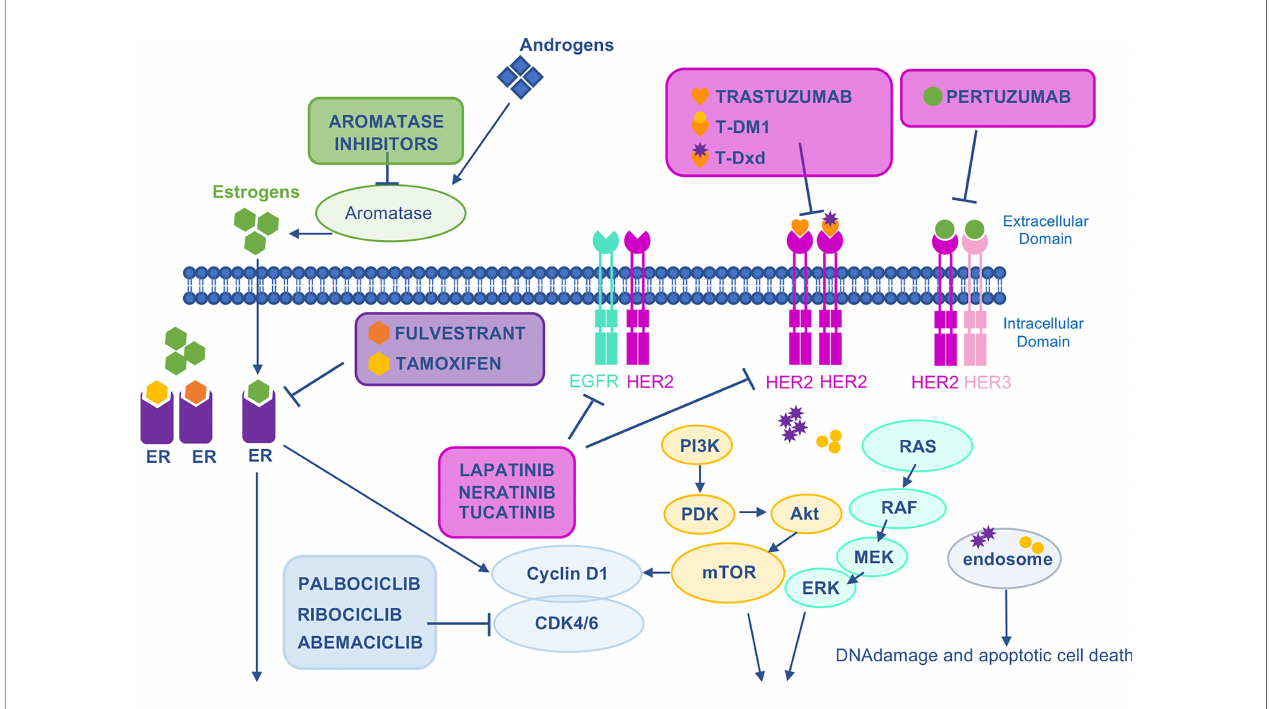
FIGURE 2 | Mechanism of action of HER2 – , ER – , and CDK4/6 – targeted drugs. HER family RTKs (EGFR, HER2, and HER3) activate several oncogenic signaling pathways such as Ras/Raf/MEK/ERK or PI3K/Akt/mTOR to stimulate growth and proliferation. Direct HER2 inhibitors include trastuzumab and the conjugates of trastuzumab with DM1 (T – DM1) or Dxd (T – Dxd). In the case of drug – antibody conjugates, upon binding of trastuzumab to HER2, the payload is internalized by endocytosis to induce DNA damage. Pertuzumab mAb binds HER2, preventing homodimerization and heterodimerization with other family members, especially HER3. Lapatinib is a EGFR/HER2 TKI that attenuates cell proliferation, cell – cycle regulation, and downstream pathways. Tucatinib is a selective HER2 TKI with minimal inhibition of EGFR. Neratinib is a pan – HER irreversible TKI. ER is a transcription factor which, under estrogen stimulation, is recruited on the promoter of its target genes to induce cell proliferation. Aromatase inhibitors prevent the aromatase – dependent conversion of androgens to estrogens, whereas fulvestrant and tamoxifen are both anti – estrogens that counteract the effects of estrogen by directly binding to the ER. CDK4 and CDK6 form complexes with CyclinD1 to stimulate proliferation. Palbociclib, ribociclib, and abemaciclib are CDK4/6 small molecule inhibitors. CDK 4/6, cyclin – dependent kinases 4/6; DM1, derivative of maytansine 1; Dxd, deruxtecan; EGFR, epidermal growth factor receptor; ER, estrogen receptor; ERK, extracellular – signal regulated kinase; HER2, human epidermal growth factor 2; HER3, human epidermal growth factor 3; MEK, mitogen – activated protein kinase kinase; mTOR, mammalian target of rapamycin; PDK, phosphatidylinositol – dependent kinase; PI3K, phosphoinositide 3 – kinase; RAF, rapidly accelerated fi brosarcoma; RAS, RAS proto –